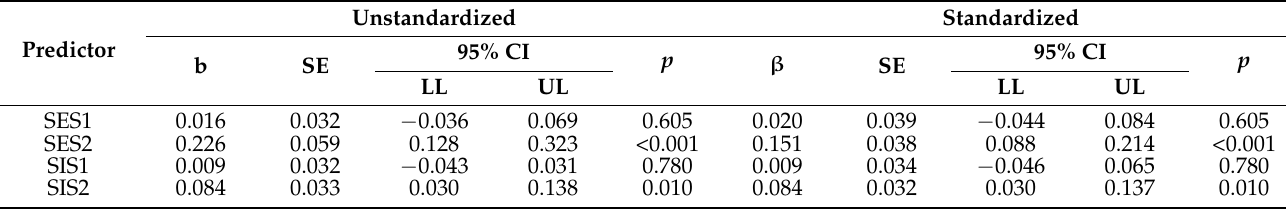
Table 5. Parameter estimates for a structural equation model where premature ejaculation was regressed on four factors of sexual excitation and